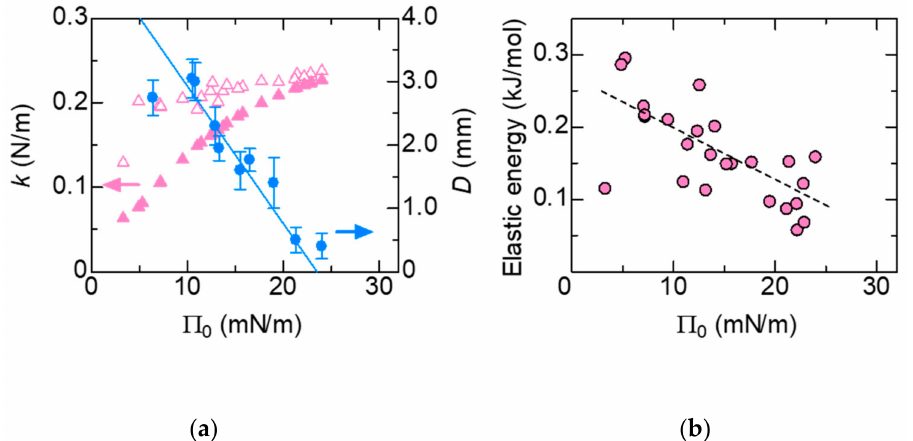
Figure 4. ( a ) Pink: Dependence of the elasticity k on Π 0 . Closed and open triangles represent data for k 0 and k 1 , respectively. Blue: Dependence of the maximum displacement of the tracer particle D on Π 0 . The solid lines are estimated from the Π –A curve (Figure 2a); ( b ) Dependence of the elastic energy on Π 0 . The dashed line is a guide to the eye.